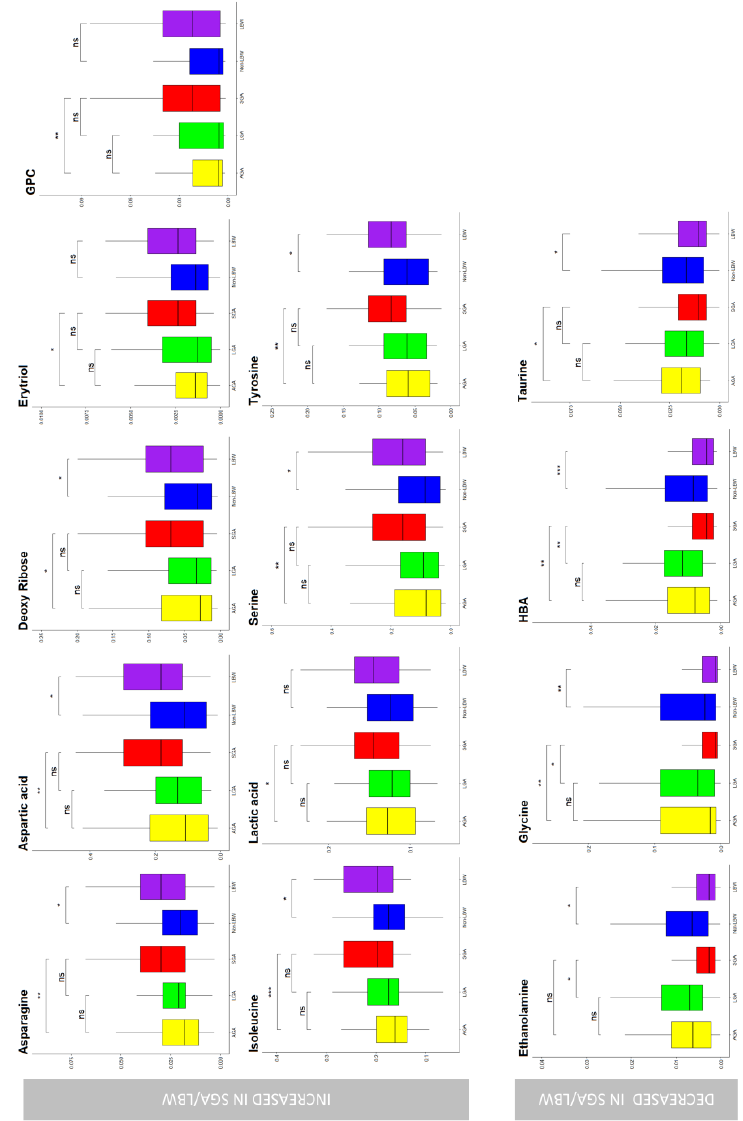
Figure 3. Box and whisker plot of the VIP metabolites. Red boxes represent the placentae of small for gestational age (SGA) newborns ( n = 118), yellow represents the adequate for gestational age (AGA) placentae ( n = 326), green represents the large for gestational age (LGA) placentae ( n = 49), blue represents the placentae of low birth weight baby (LBW) ( n = 124), while purple represents the non-low birth weight baby (non-LBW) ( n = 369). The y axes represent the normal- ized metabolite chromatographic area. GPC = Glycerophosphocoline; HBA = Hydroxybutyric acid; ns = not significance. Ns indicated not significant difference in concentration, * p -value < 0.05, ** p -value < 0.01, *** p -value <